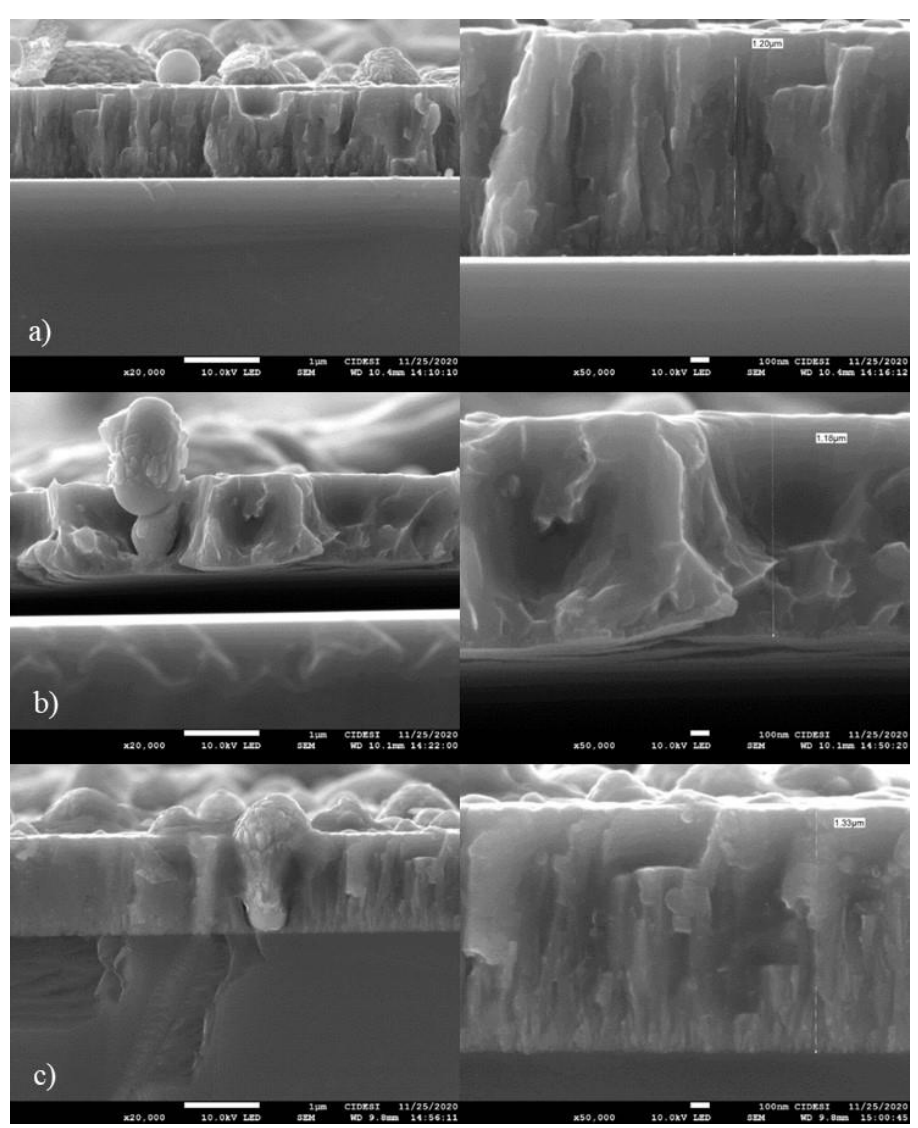
Figure 2. FE-SEM micrographs of the cross sections of the arc-PVD TiO x coating with Ar and O 2 flow ratios of ( a ) 300/100, ( b ) 400/100, and ( c ) 440/60.